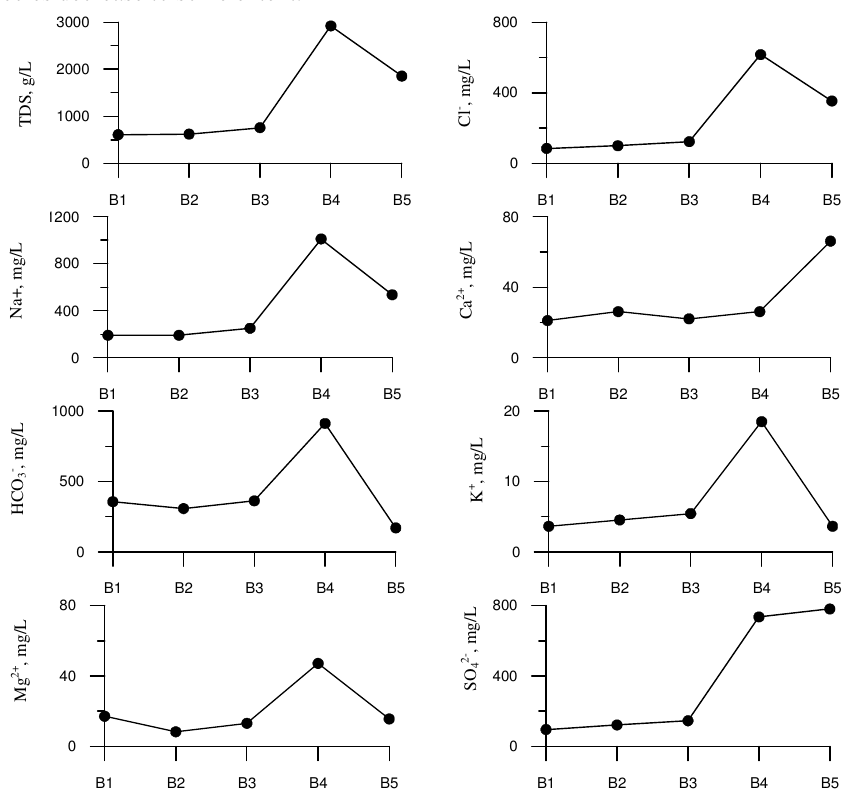
Figure 2. Changes of TDS and concentrations of major species along flow